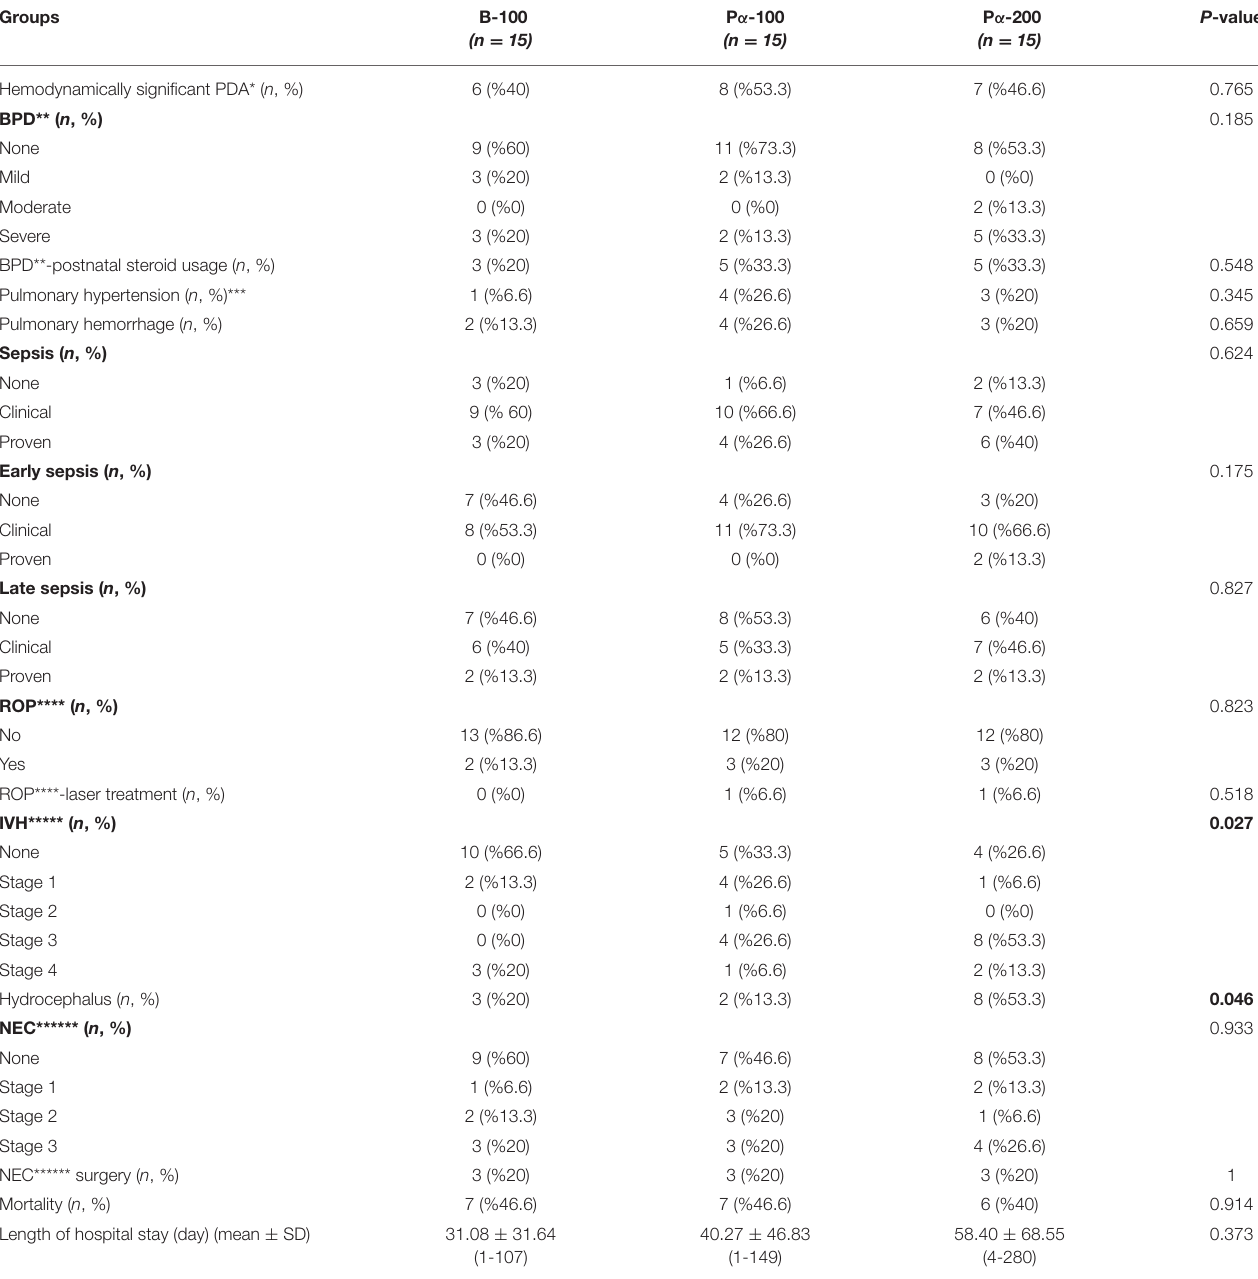
TABLE 3 | Comparison of short morbidity and mortality of the groups.